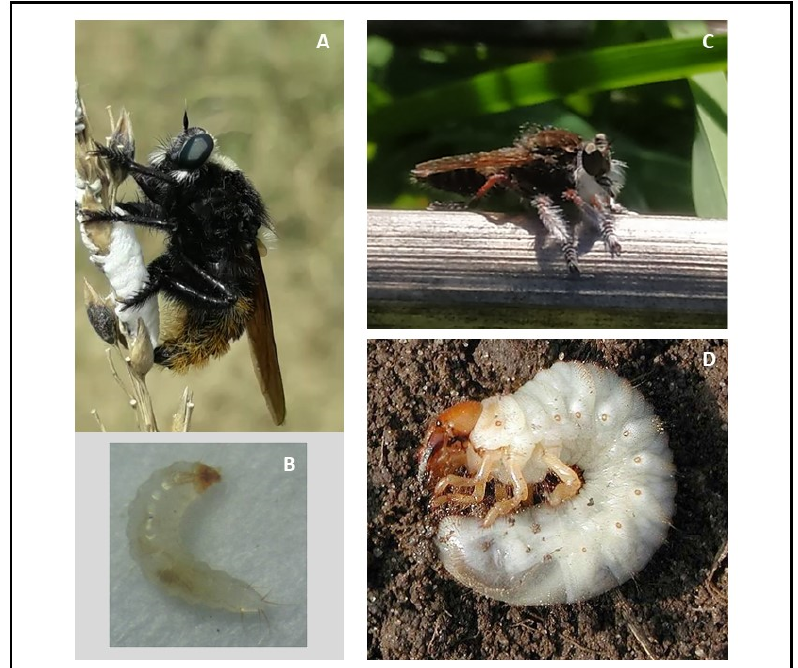
Figure 1. Parasitoid and host species. ( A ) Mallophora ruficauda female ovipositing in a plant. ( B ) Larva of second instar of M. ruficauda . ( C ) Mallophora bigoti female resting on a dry stick. ( D ) General aspect of a third instar white grub.